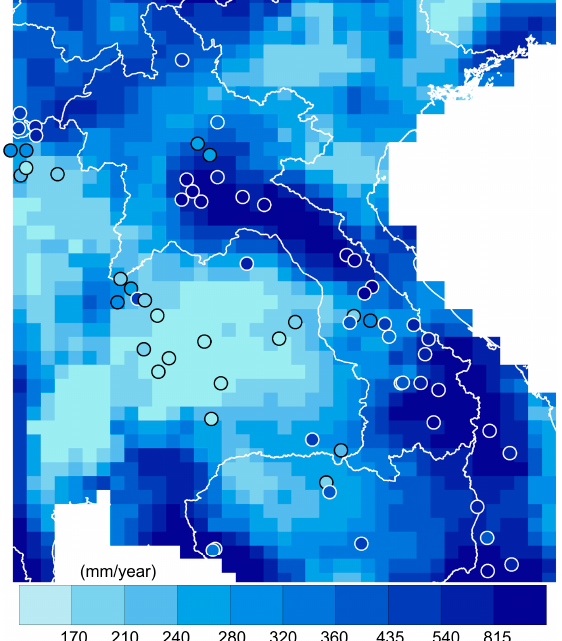
Figure 4. Median annual groundwater recharge in the Lower Mekong Basin. Circles are located in the centroid of the gauged catchments and their corresponding values are estimated with the local minimum method ( Q B estim ). Un-gauged values in square grid cells are predicted by multiple log-linear regressions ( Q B pred ). The graduated color-scale indicates the values for both Q B estim and Q B pred .